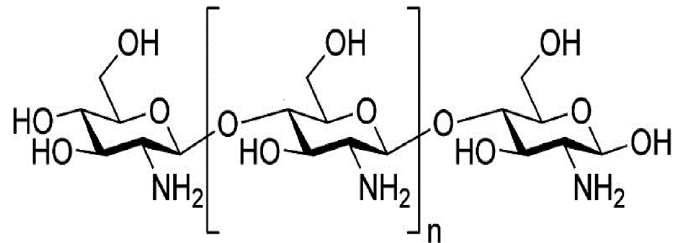
Figure 1. Structure of chitosan.